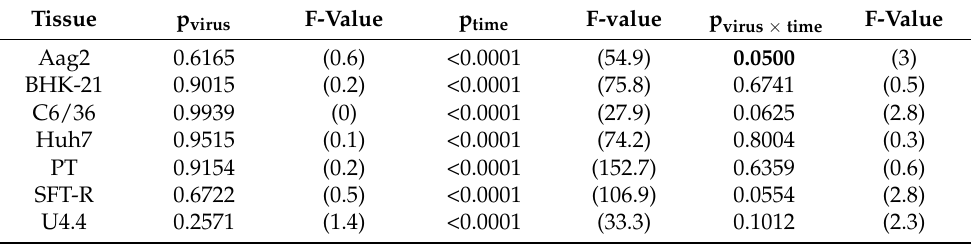
Figure 3. Replication kinetic in BHK-21 ( A ) , SFT-R ( B ) , Huh7 ( C ), PT ( D ) , U4.4 ( E ) , C6/36 ( F ) and Aag2 ( G ) cells. All cell lines were infected with an MOI of 0.1 and incubated for the indicated time. Each replication kinetic was repeated three times. Table 1. Results from the full model, including all four viruses. Significant p -values are marked in